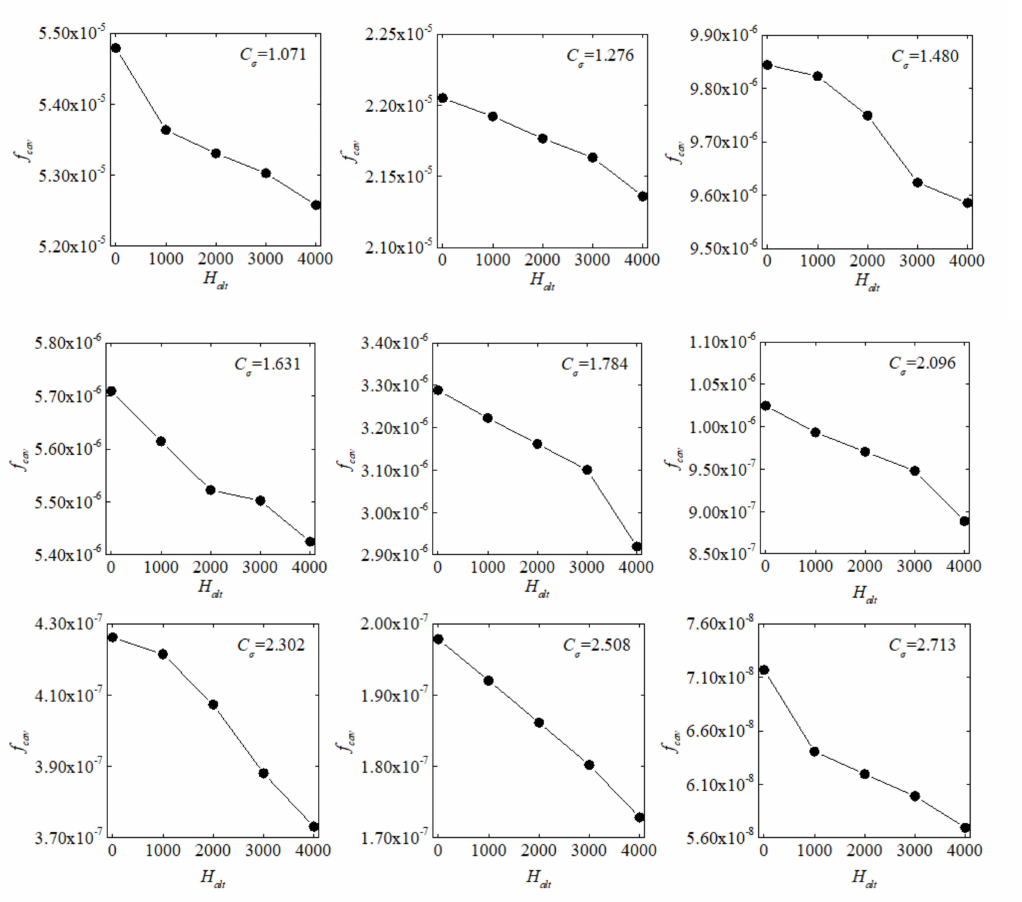
Figure 5. Cavitation vapor proportion among different H alt at a specific C σ